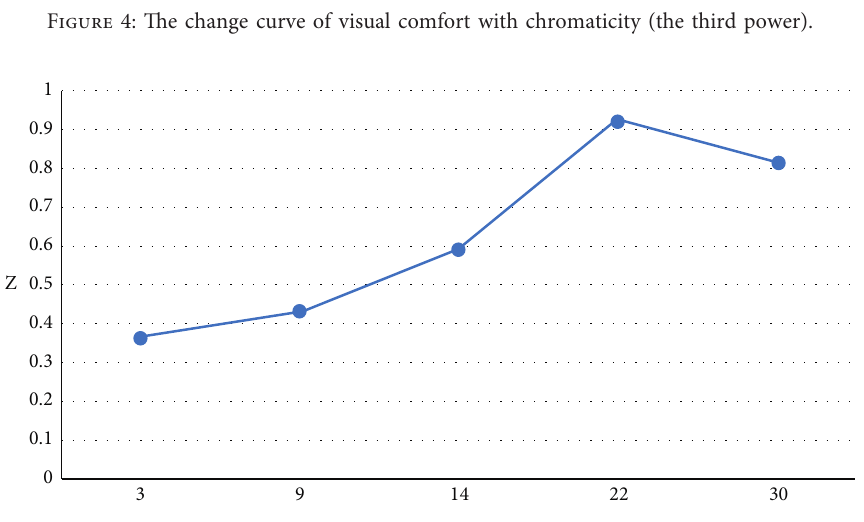
Figure 5: The curve of visual comfort change with chromaticity (fourth power).